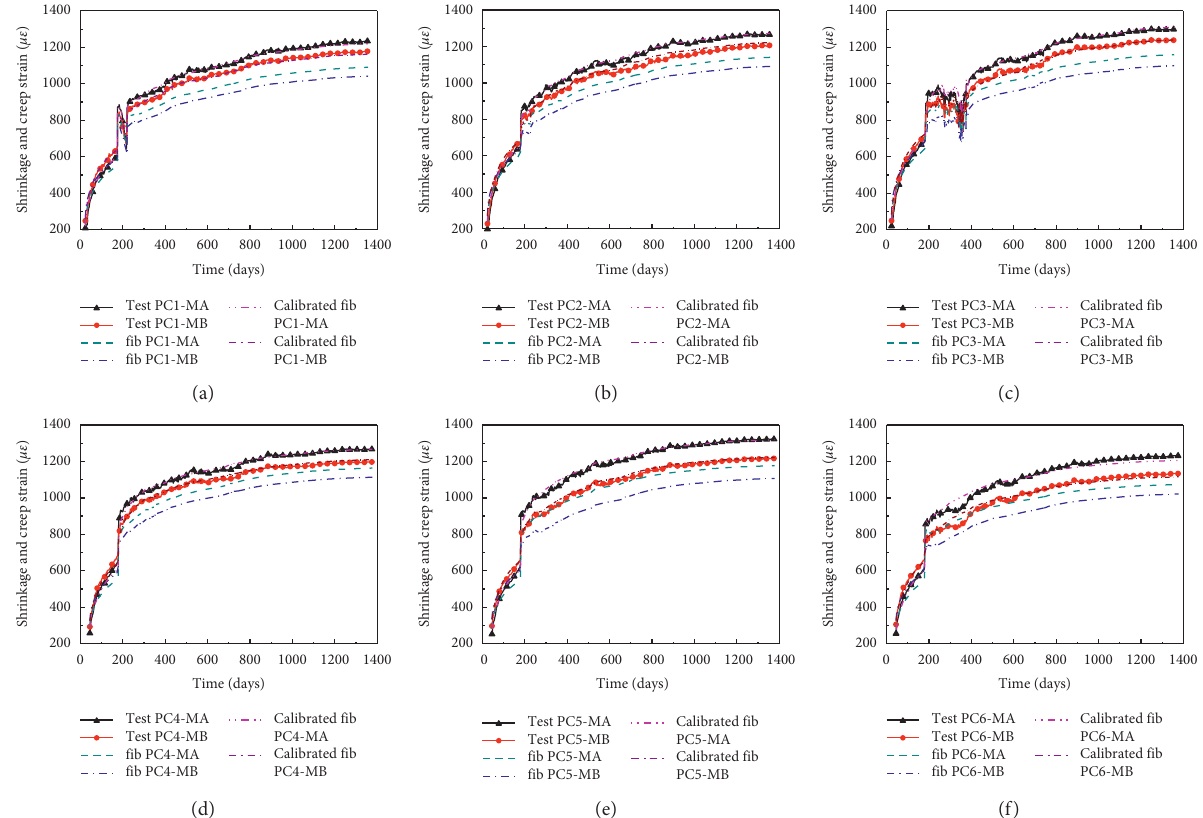
Figure 10: Comparison between the experimental and the predicted strains: (a) PC1; (b) PC2; (c) PC3; (d) PC4; (e) PC5; (f) PC6.